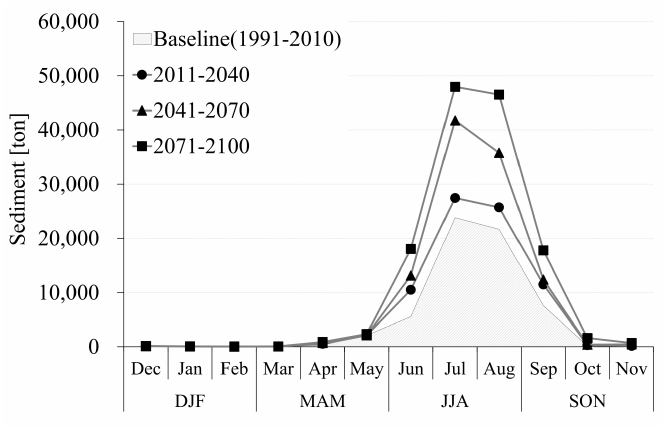
Figure 13. Future variation of monthly sediment yields.